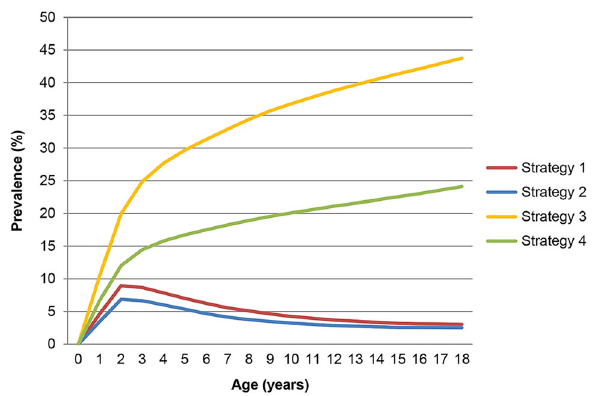
Fig. 3 Prevalence by age for allergic rhinitis